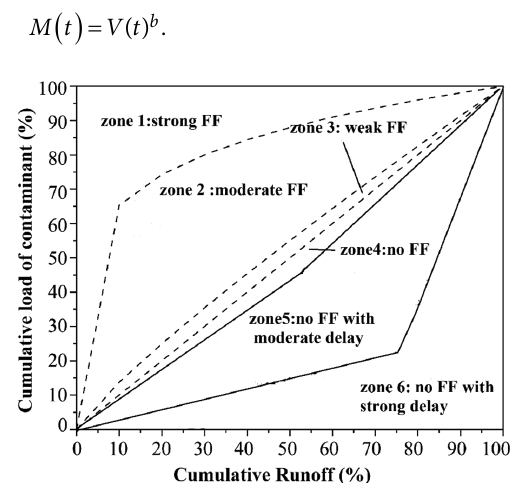
Figure 2. The M-V curve Zones depending of the value of the coefficient b adapted from Bertrand-Karjewiski (1998) and Tabei and Droste